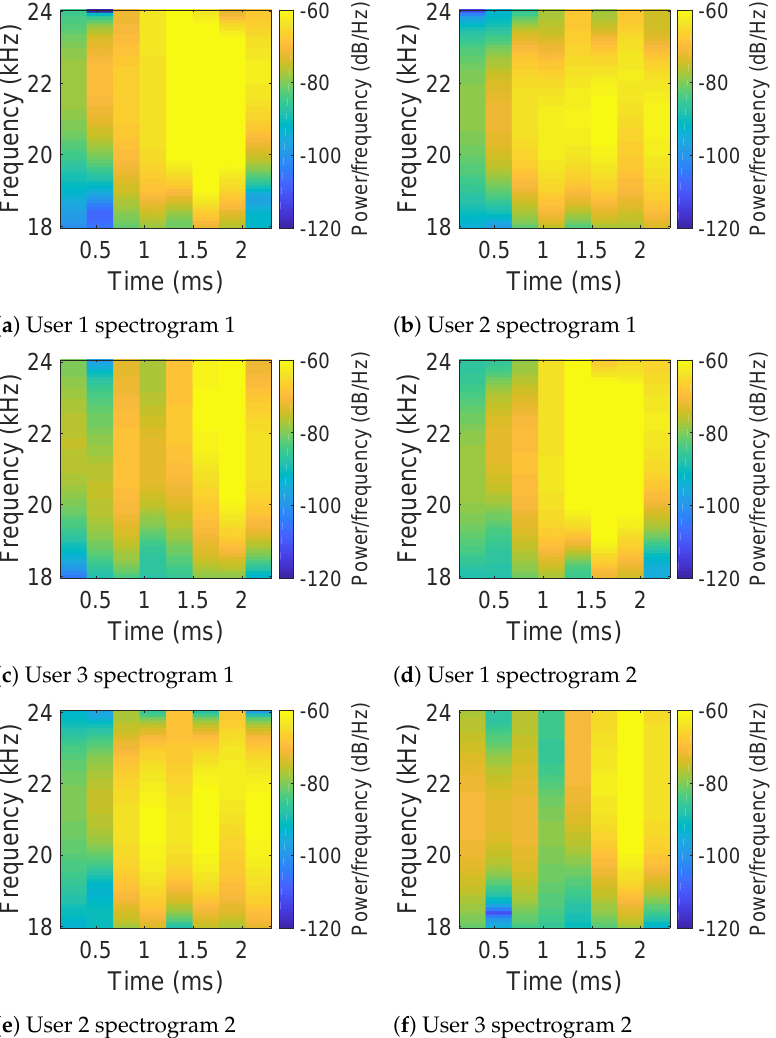
Figure 8. Spectrograms of echoes obtained by the top microphone in the hand geometry section for three different